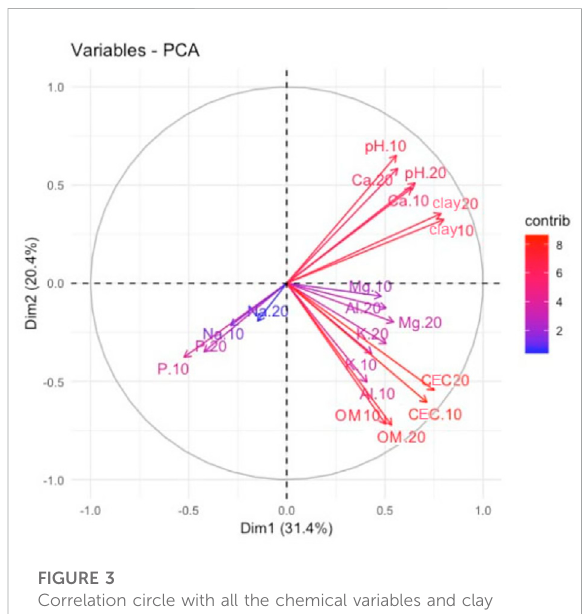
FIGURE 3 Correlation circle with all the chemical variables and clay content to buildthesoil fertilityESvaluationindicator.Orotoyriver basin.